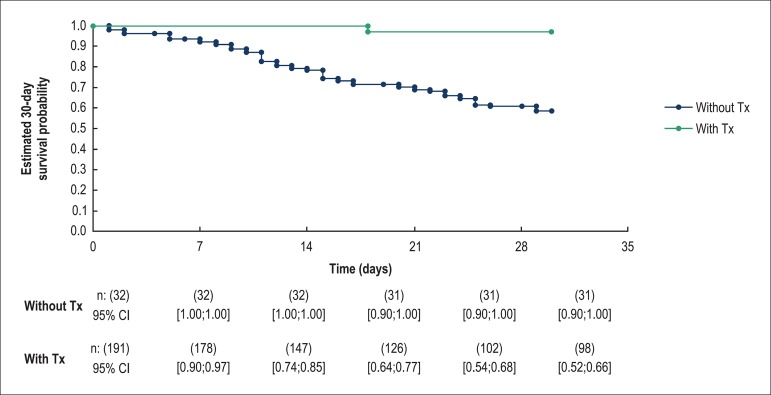
Comparison of 30-day mortality between transplant patients (with Tx) and
non-transplant patients (without Tx). n: number of patients at risk;
95%CI: 95% confidence interval. P-value was calculated using the
Log-rank test: p < 0.001.